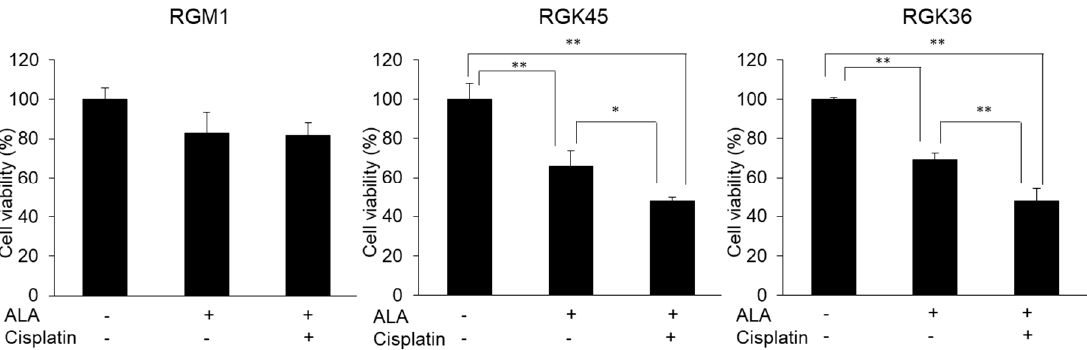
Figure 7. The effect of combination therapy with both cisplatin and photodynamic therapy (PDT). Cells were treated by 10 μ M cisplatin, then exposed 1 mM ALA. Cytotoxicity of PDT enhanced by cisplatin treatment in both RGK45 and RGK36. Data are expressed as means ± SD (n = 4). * p < 0.05, ** p < 0.01.